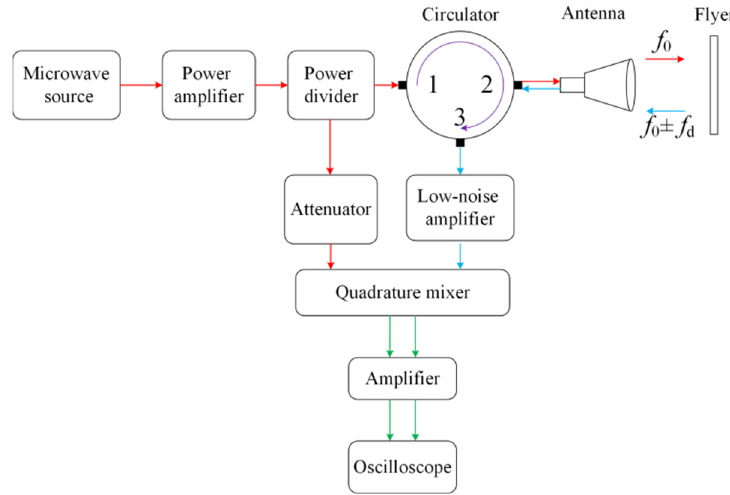
Figure 16. Schematic diagram of microwave interferometer.